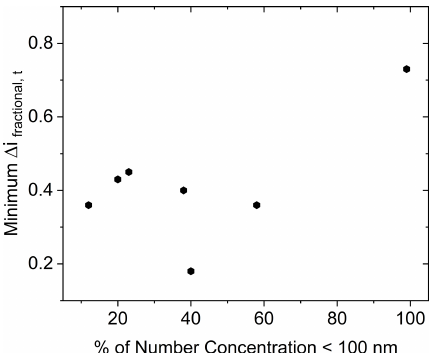
Figure 10. Minimum (cid:49)i fractional ,t as a function of percentage of number concentration of particles (within a distribution) below 100nm in aerodynamic